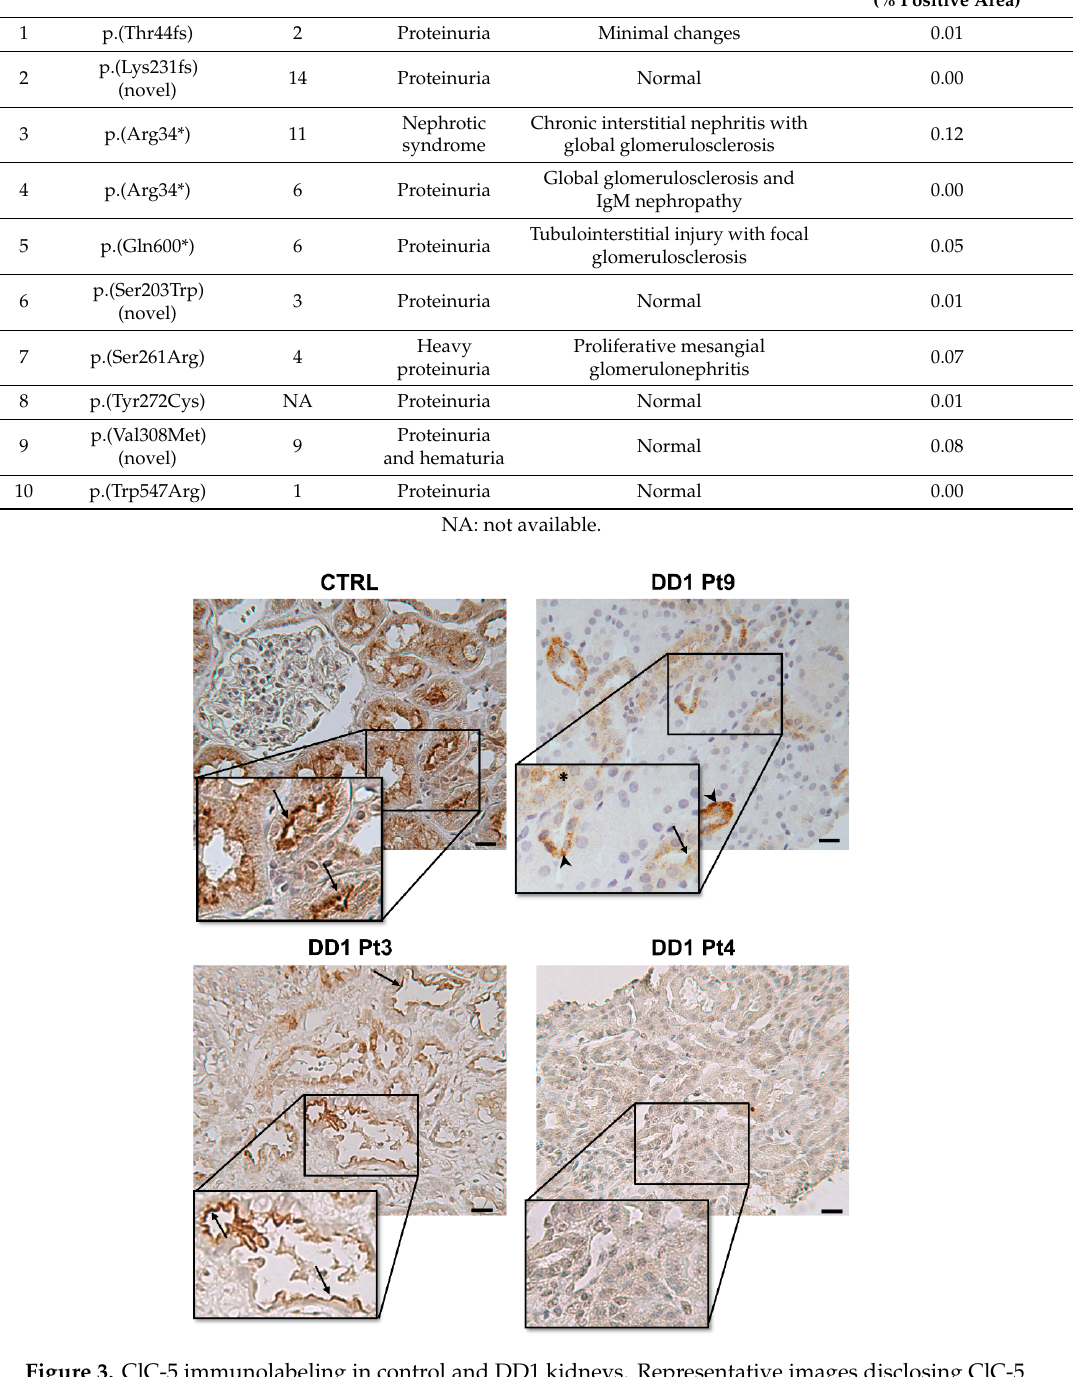
Table 2. Morphometric evaluation of tubular ClC-5 immunolabeling in 10 DD1 patients’ kidney biopsies. Patient